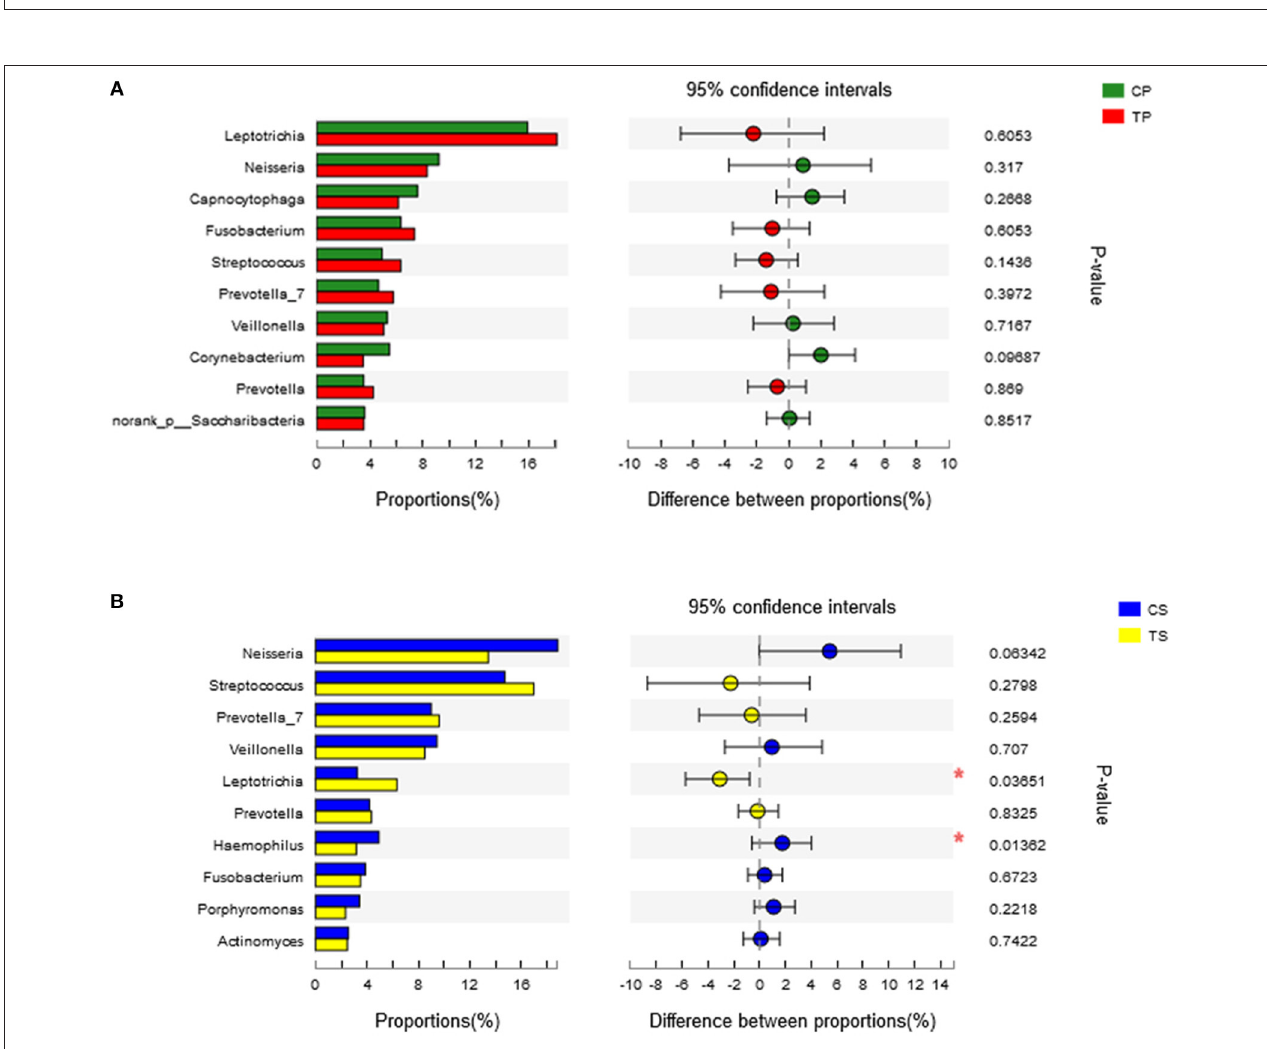
FIGURE 3 | Wilcoxon rank-sum test bar plot on genus level. (A) Results of the CP and TP groups. (B) Results of the CS and TS groups. *Represents a significant difference ( P < 0.05).